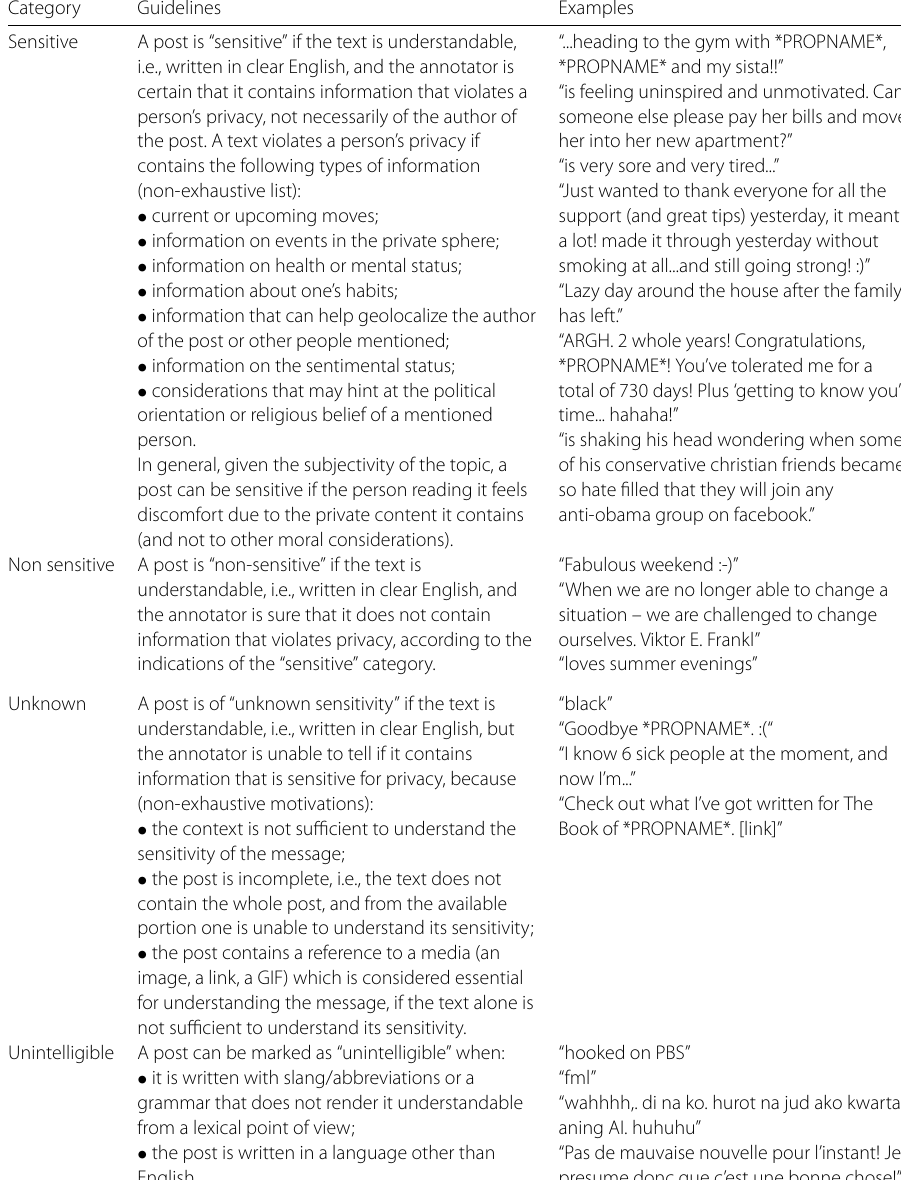
Table 1 Guidelines and examples for the annotations